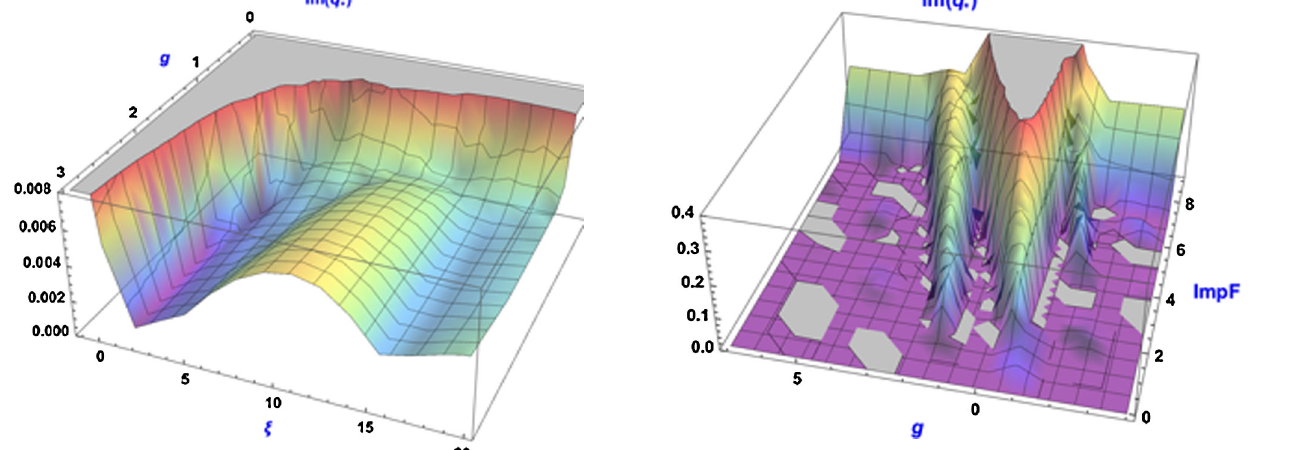
FIG. 30. Growth rate for the single LHC bunch, reactive damper and zero chromaticity. Compare with Fig. 12 for the broadband impedance and Fig. 1 for the two-particle model.